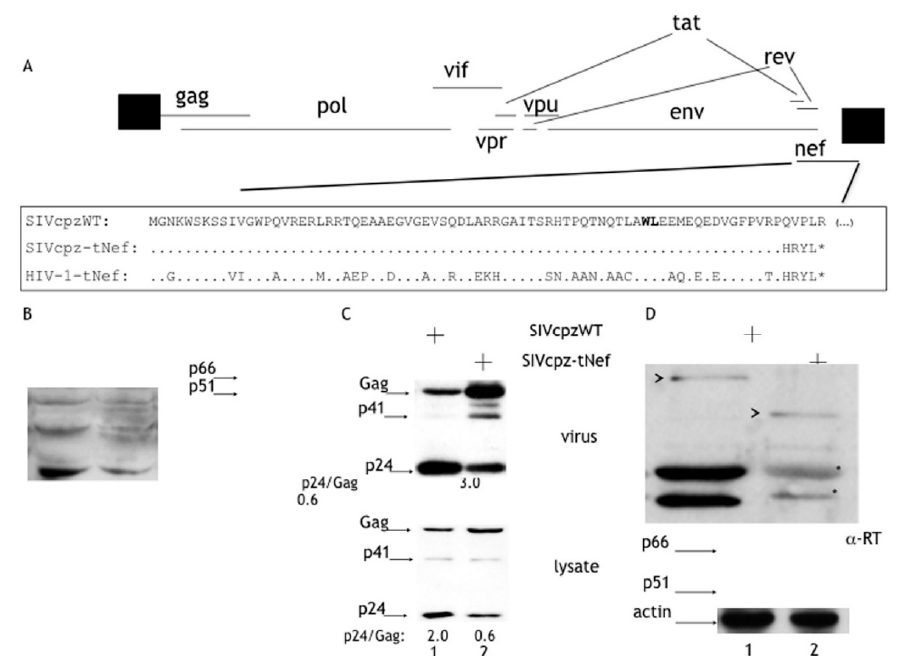
Figure 1. Schematic representation of the SIV chimpanzee (SIVcpz) constructs. ( A ) The genomic organization of SIVcpz and HIV-1 is represented. All open reading frames are shown, and the N-terminal of the Nef ORF is expanded in the box. Sequence coding for the N-terminal domain of SIVcpz and HIV-1 Nef is disrupted to generate the truncated mutants SIVcpz-tNef and HIV-1-tNef. The N-terminal domain of Nef from SIVcpzWT is used as a reference sequence. The SIVcpz-tNef and HIV-1-tNef peptides have a truncated amino acid sequence (HRYL) followed by a premature termination codon. The protease cleavage site within Nef is highlighted (WL), and the arrows indicate stop codons; ( B ) SIVcpz-tNef progeny are non-infectious. Viral infectivity was measured by subjecting the TZM-bl indicator cell line to serial dilutions of normalized supernatants of transfected Hek-293T cultures, and 48 h later, the number of blue foci was scored. Error bars are the standard deviation of the mean. The results are representative of five independently-produced sets of viral stocks; ( C ) Cell-free supernatants from Hek293T cells expressing SIVcpzWT and SIVcpz-tNef were harvested and concentrated through a 20% sucrose cushion. Lysates of Hek293T cells expressing SIVcpzWT and SIVcpz-tNef were harvested 48 h after transfection. Viral and cell lysates were processed for Western blot with polyclonal α -p24, which recognizes Gag (55 kDa), p41-MACA (41 kDa) precursors and the mature p24-CA (24 kDa) protein indicated by arrows. SIVcpz-tNef had a noticeable accumulation of Gag and the partially-processed precursors p41 both in virus and cell lysates. As a measure of the processing efficiency, the p24/Gag ratio was calculated. SIVcpz-tNef processing was reduced by 5-fold in viral lysates and 3-fold in cell lysates; ( D ) The expression of the Pol-associated proteins was also evaluated, viral and cellular lysates were processed for Western blotting with polyclonal α -RT, which recognizes RT (51 kDa and 66 kDa) and unprocessed or partially-processed GagPol. Arrowheads point to partially-processed GagPol of 128 kDa in SIVcpzWT and 110 kDa in SIVcpz-tNef. No RT products were observed in viral and cell lysates of SIVcpz-tNef. Asterisks point to two unspecific bands, and α -actin was used as the loading control.